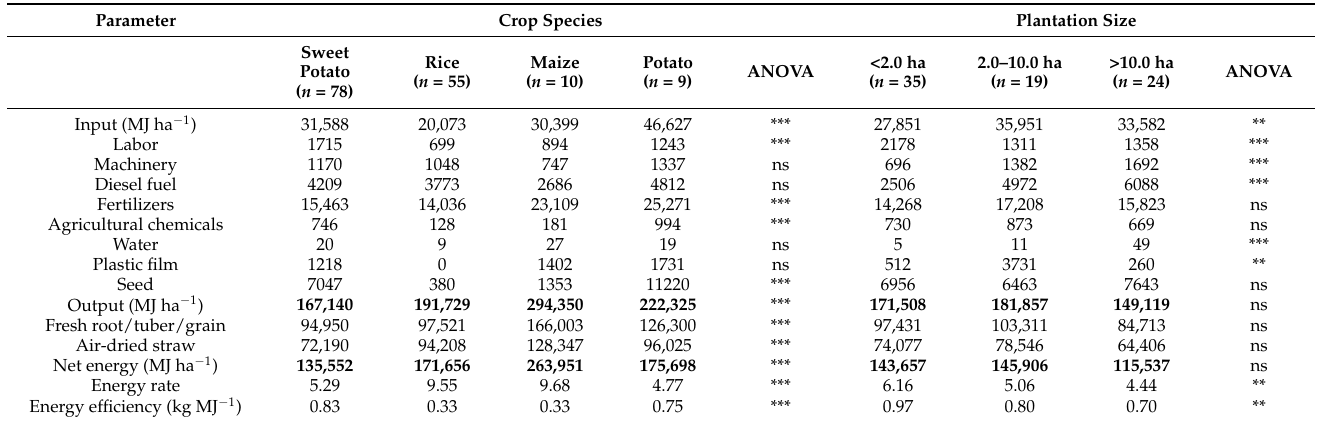
Table 5. Energy input and output of different crops production (including sweet potato, rice, maize, and potato) and different plantation sizes of sweet potato production in Guangdong.